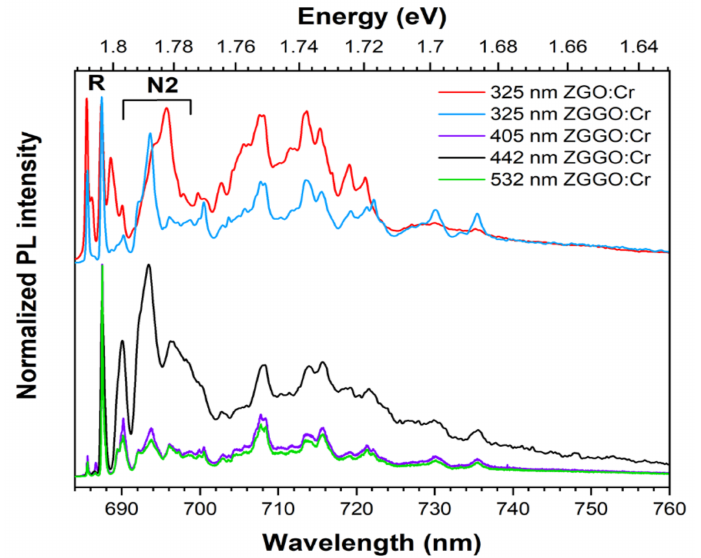
Figure 6. The 15 K PL spectra of ZGGO:Cr obtained upon excitation on the defect absorption band and intraionic 4 A 2 → 4 T 1 , 4 T 2 transitions. The spectrum obtained for the ZGO:Cr under 325 nm excitation (onset of band-to-band absorption) was added for comparison purposes.